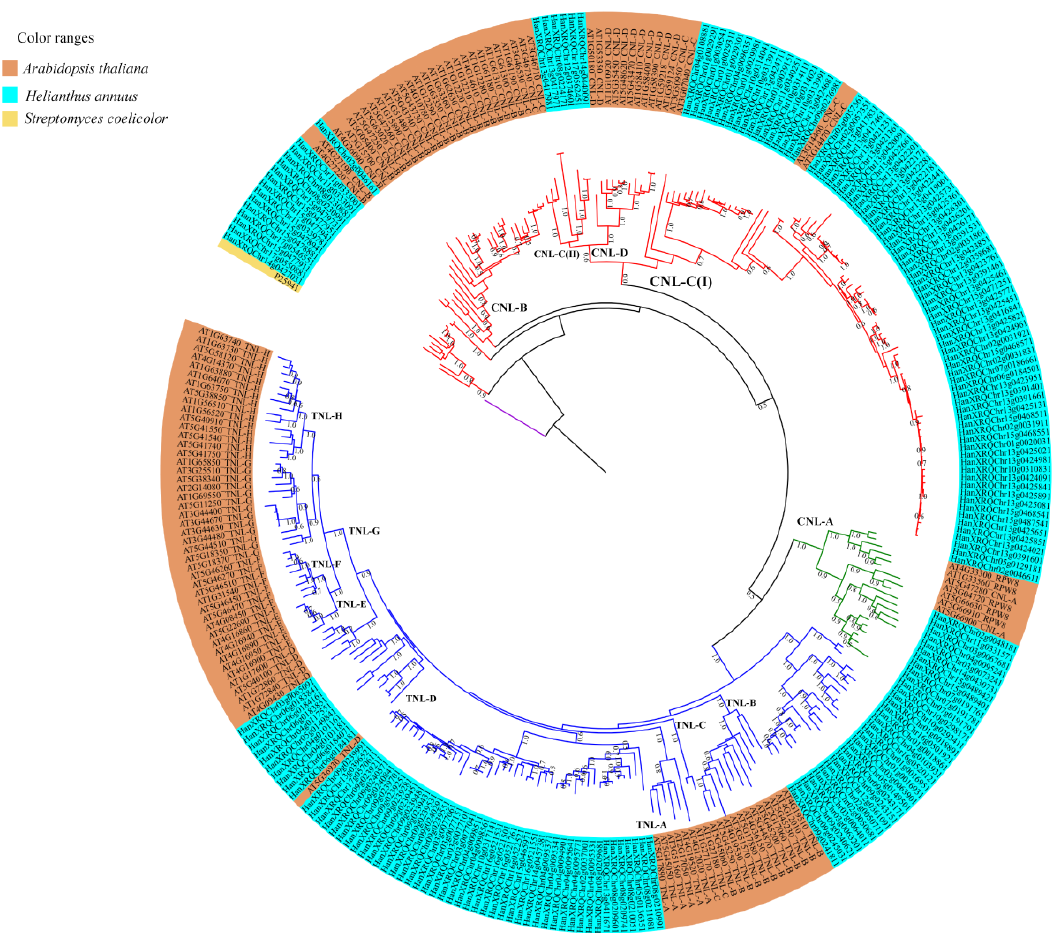
Figure 4. Maximum likelihood (ML) tree featuring NBS domain amino acid sequences of the CNL, TNL, and RNL genes from Arabidopsis thaliana (AT; orange) and Helianthus annuus (light blue). The ML tree was reconstructed using JTT + G + I (Jones–Taylor–Thornton with γ distribution and invariant sites) evolutionary model with 1000 bootstrap replicates. The ML tree was rooted using Streptomyces coelicolor NBS-containing protein, P25941, as an outgroup (yellow). The clades are color-coded: TNL in blue, CNL in red, RNL clade in green, and outgroup in purple. Subclades are labeled as CNL-A to CNL-D and TNL-A to